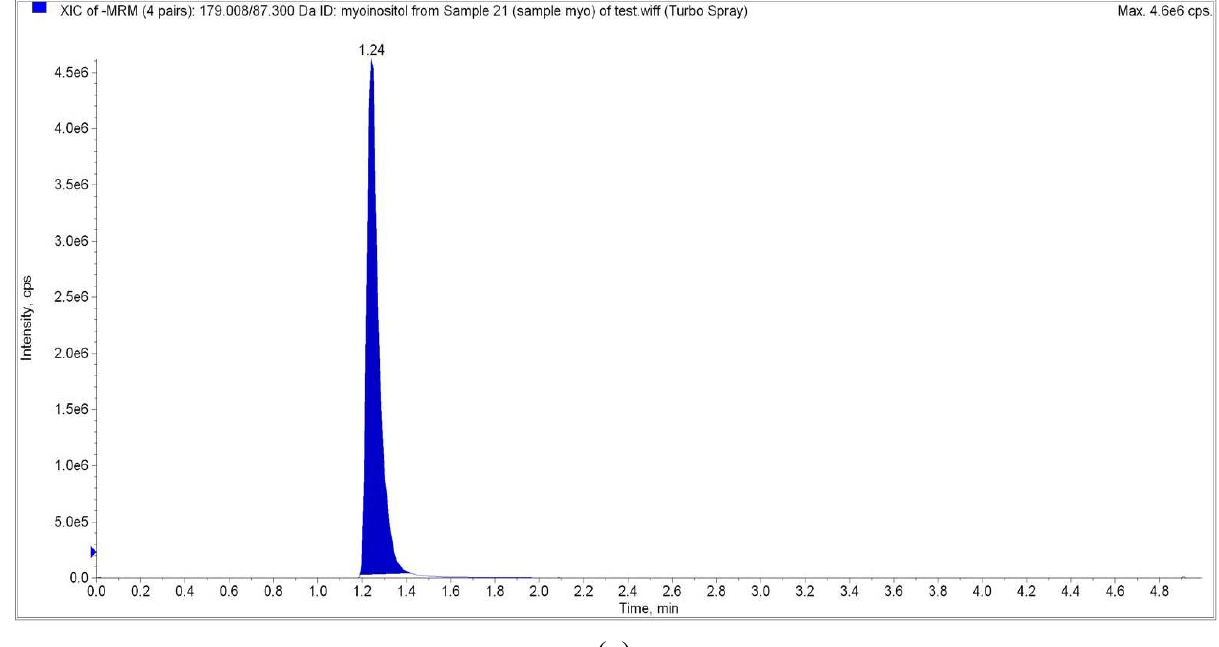
Figure 5. ( a ) LC-MS/MS analysis on crystals isolated from red dragon fruit where the peak and retention time was observed at 1.2 min with a 179 m/z precursor ion; ( b ) LC-MS/MS analysis on myo -inostiol standard where the peak and retention time was observed at 1.2 min with a 179 m/z precursor ion which is identical to the crystal sample from red dragon